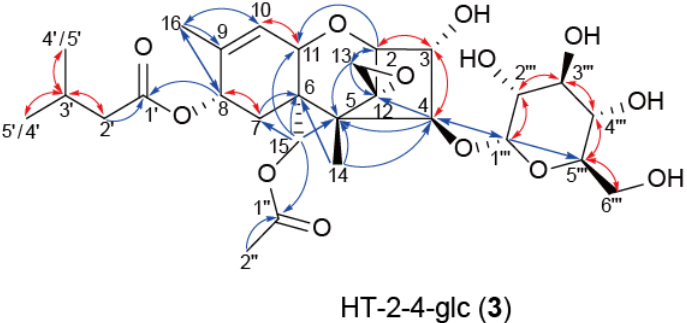
Figure 5. Determination of the structure of 3 . The red and blue arrows indicate 1 H– 1 H correlation spectroscopy (COSY) and heteronuclear multiple bond coherence (HMBC) correlations, respec- tively.